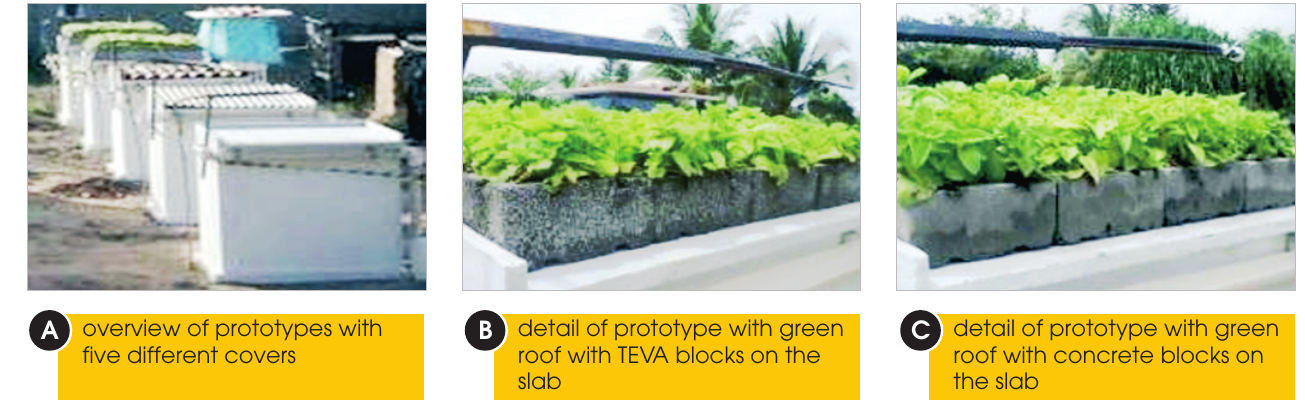
overview of prototypes with five different covers Figure 2 Prototypes built in area with few nearby buildings